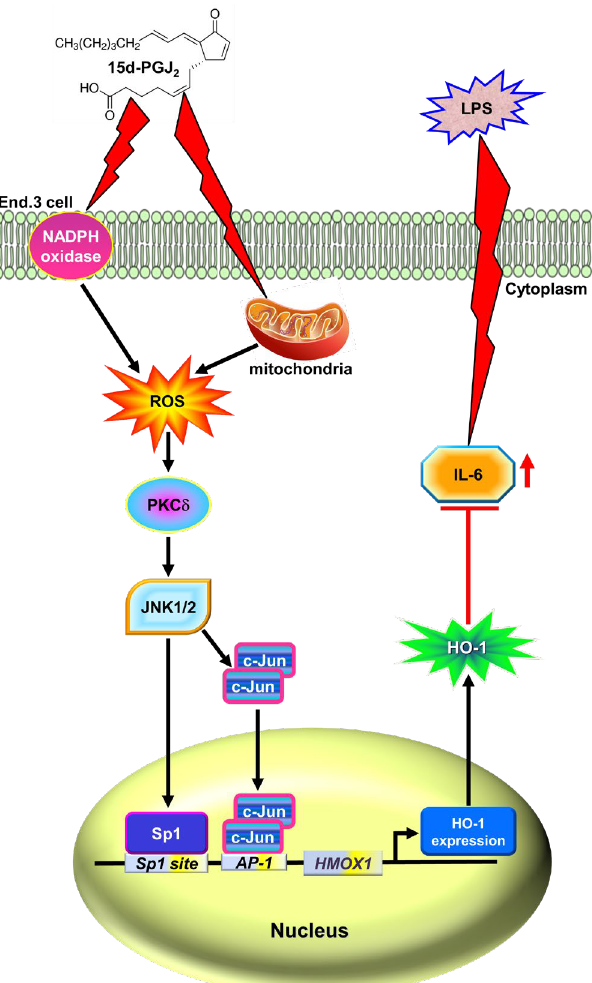
Figure 8. Schematic signaling pathways are involved in 15d-PGJ 2 -induced HO-1 expression protect- ing against LPS-induced IL-6 secretion in bEnd.3 cells. 15d-PGJ 2 stimulates NOX- and mitochondria- derived ROS generation, which sequentially activates PKC δ , JNK1/2, and transcription factor Sp1 or c-Jun activity. Activated Sp1 and c-Jun are translocated into the nucleus and then bind with respective Sp1 and AP-1 binding sites on the HO-1 promoter, leading to the induction of HO-1 expression. Moreover, upregulation of HO-1 by 15d-PGJ 2 attenuates LPS-induced IL-6 expression and secretion, which could protect against inflammatory responses in bEnd.3 cells. Abbreviations: HMOX1 : heme oxygenase 1 gene; Mito: mitochondria. ⊥ : inhibition; ↑ :